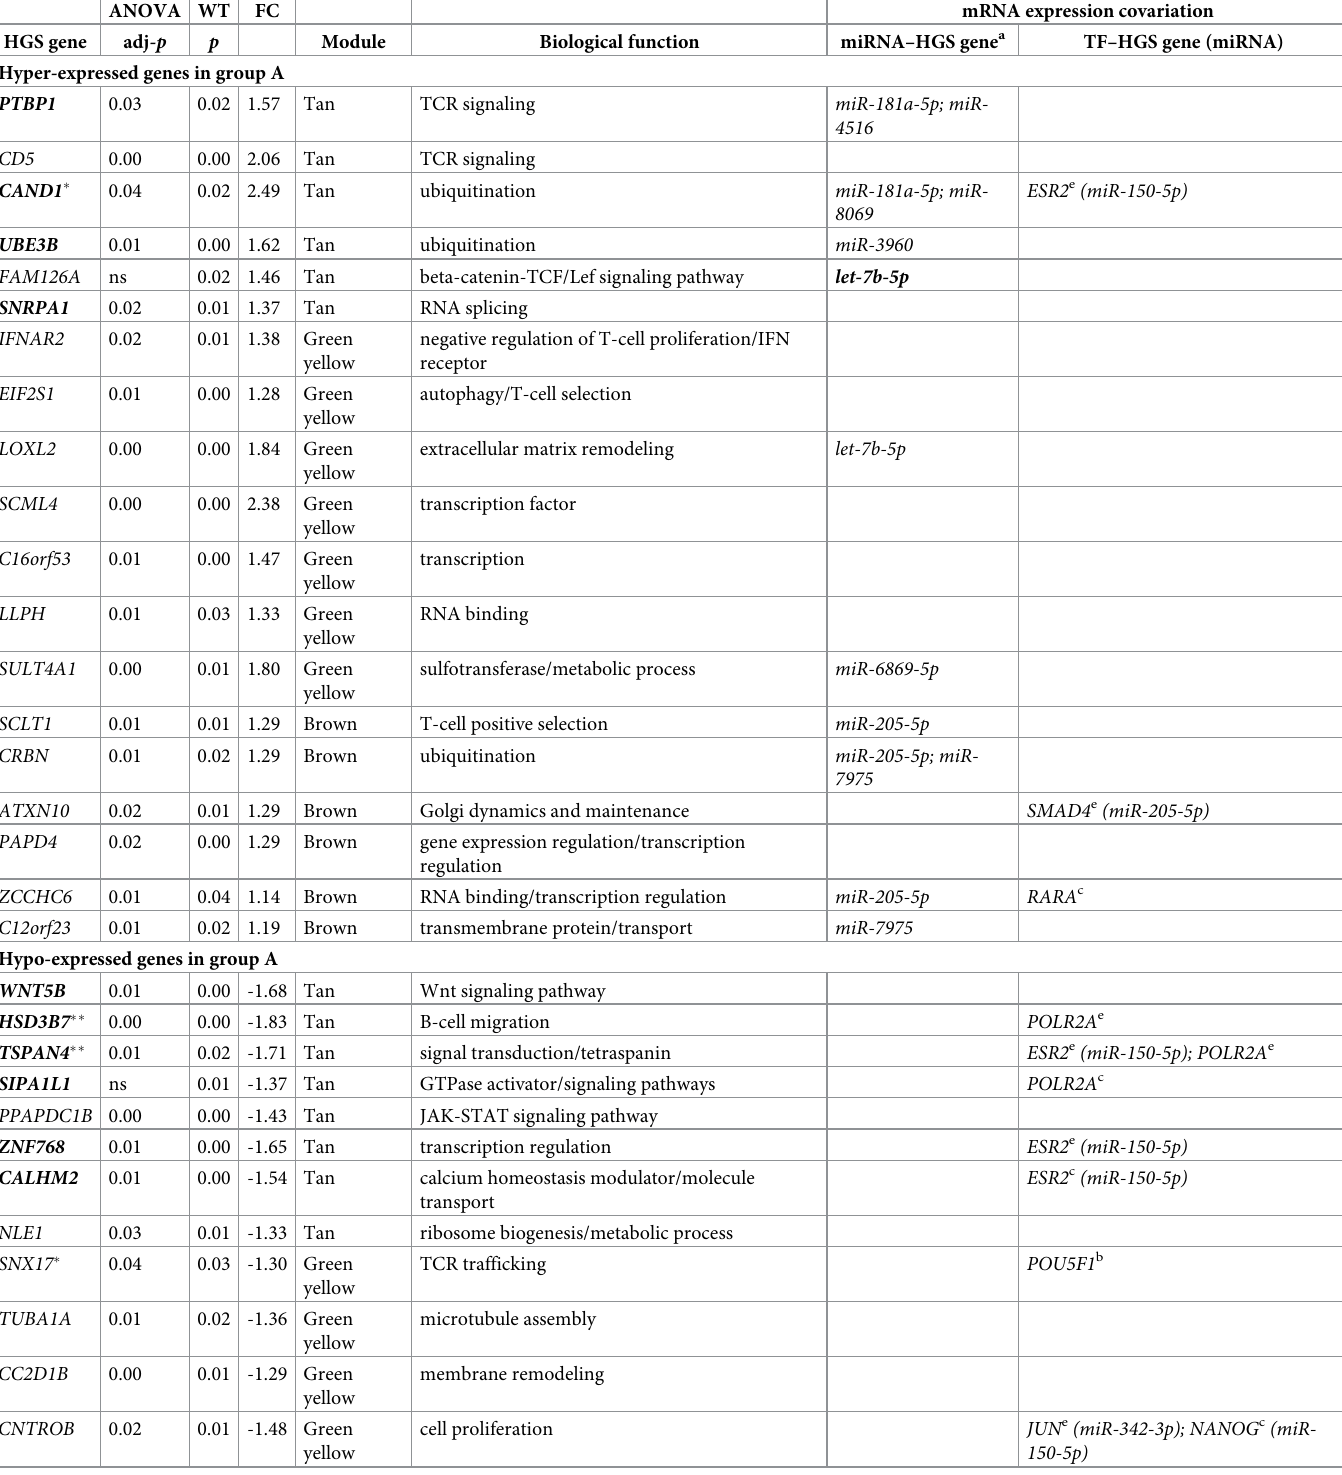
Table 2. Biological functions and TF-miRNA-HGS gene co-expression correlations for HGS genes found in modules significantly associated with the groups A and